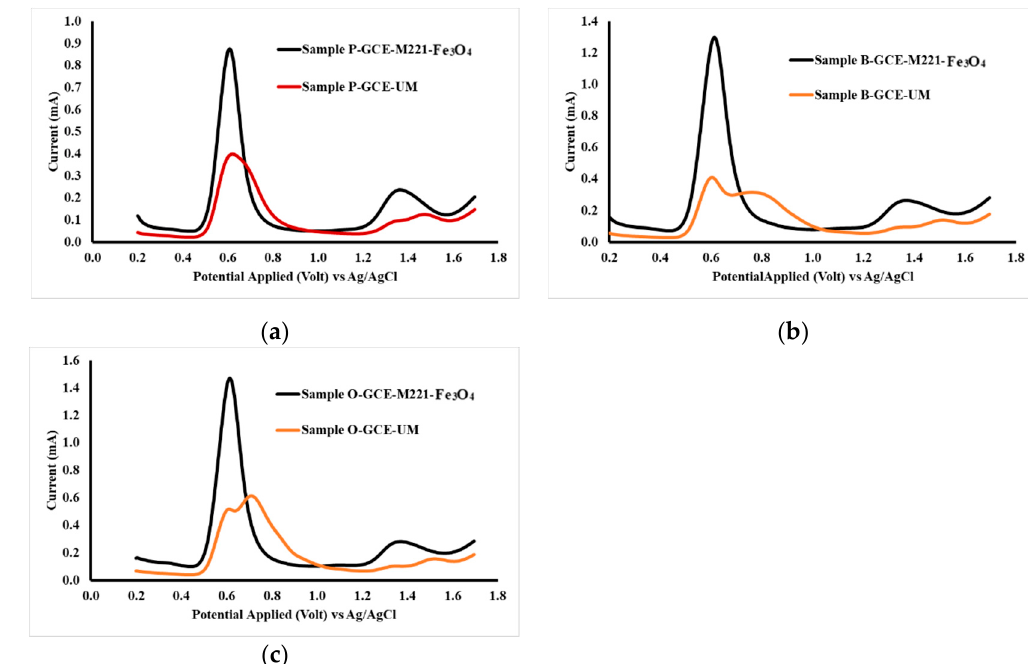
( b ) Figure 9. DPV acetaminophen and caffeine voltammograms at concentrations of 50–900 µM in PB pH 2 ( a ) and the curve of the relationship of acetaminophen and caffeine concentrations to peak currents ( b ), measured by a working electrode of GCE-M221-Fe 3 O 4 . The application of the electrodes for measurements was carried out on headache medicines from